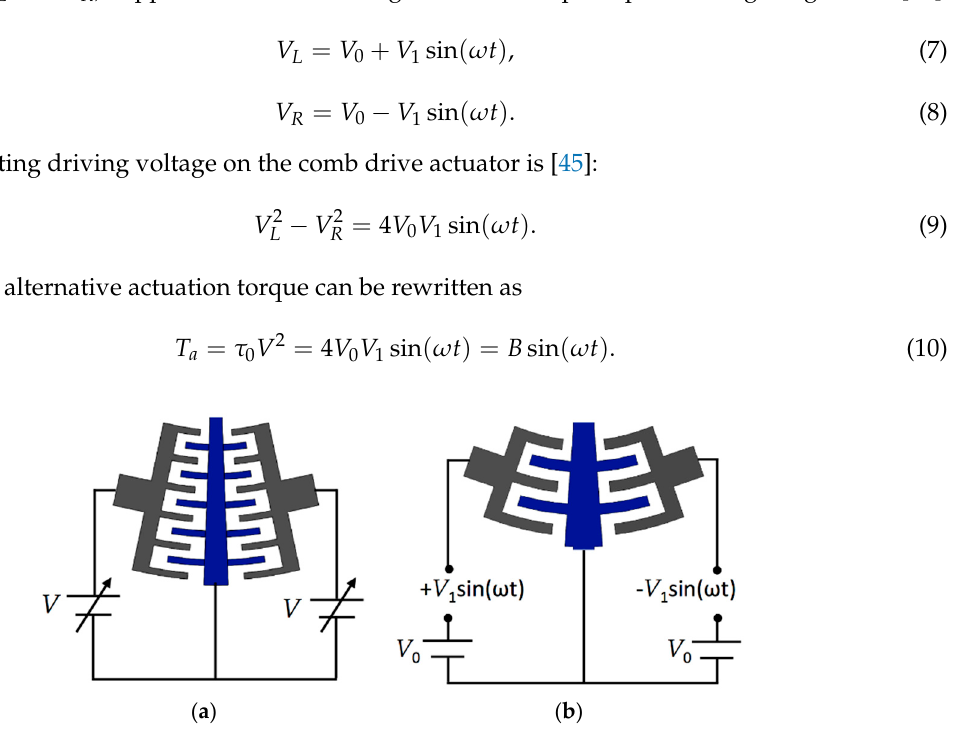
Figure 7. Schematic view of the electrical circuits with the dc and ac bias voltages of ( a ) electrostatic and ( b ) electrodynamic actuators of the microgripper.